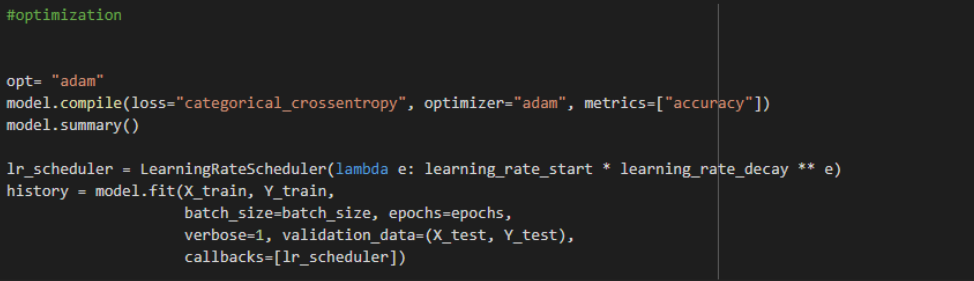
Figure 7. Selection of optimizer and loss function for output accuracy tuning.